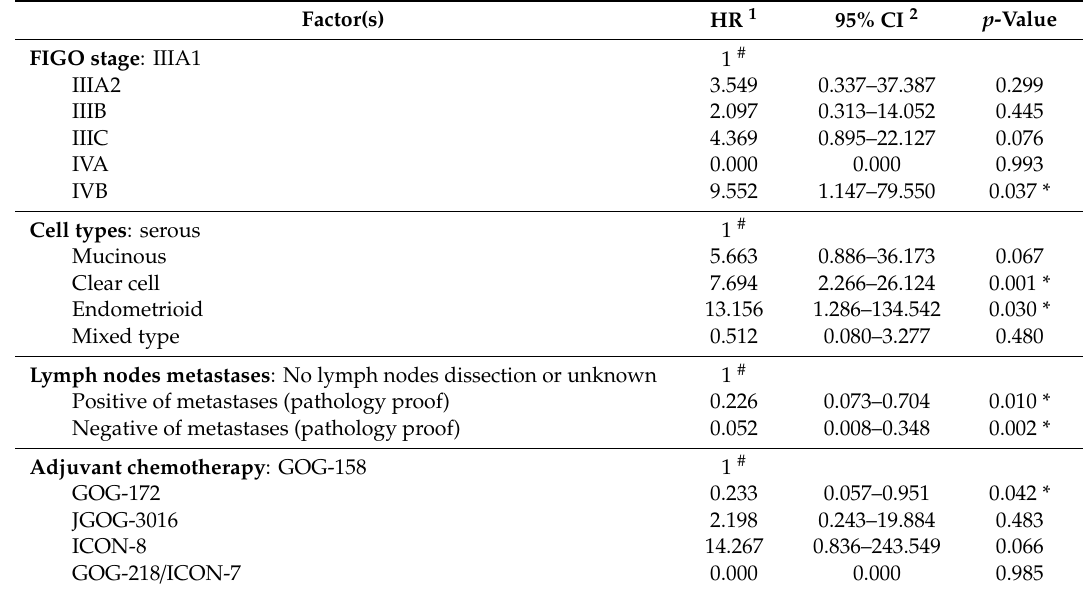
Table 11. Cox regression hazard model for mortality in optimally debulked